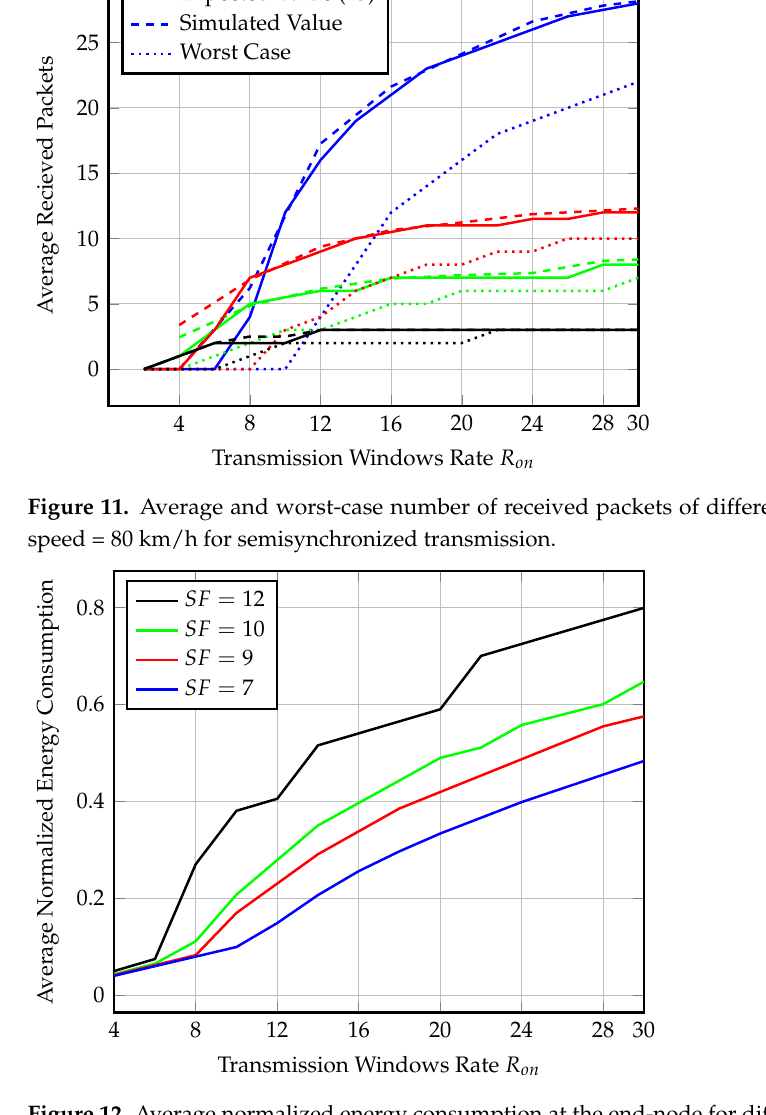
Figure 12. Average normalized energy consumption at the end-node for different SF and R on values at speed = 80 km/h for semisynchronized